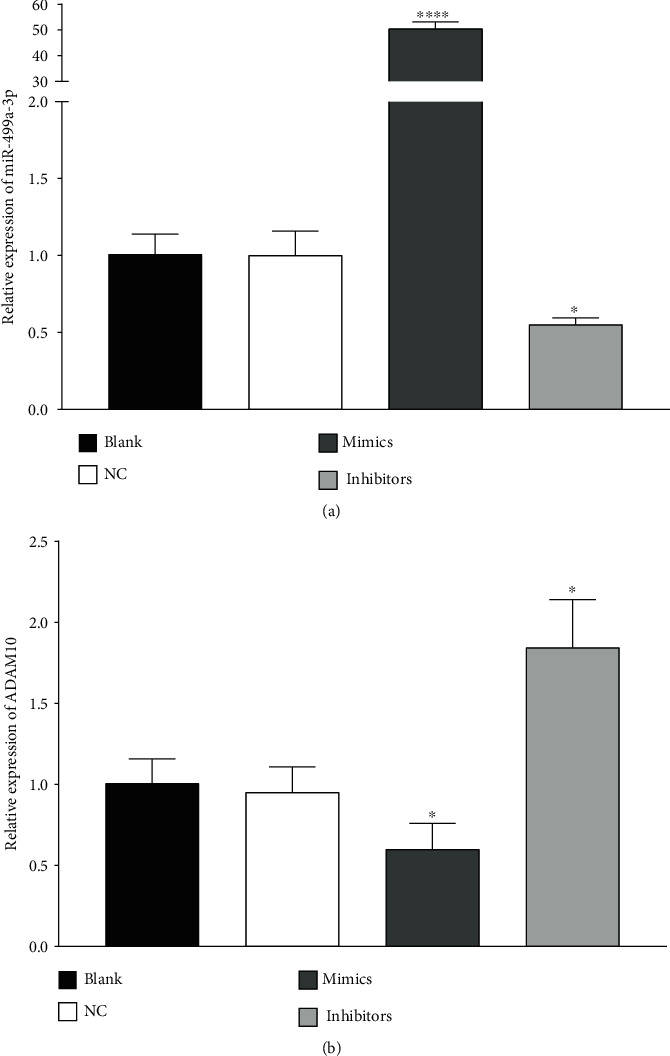
Transcription of miR-499a-3p and ADAM10 in different cell groups. (a) Transcriptions of miR-499a-3p after transfection in the blank, NC, mimics, and inhibitors groups were determined by RT-PCR. (b) Transcriptions of ADAM10 after transfection in the blank, NC, mimics, and inhibitors groups were determined by RT-PCR. All results were expressed as the mean ± standard deviation (n = 3).